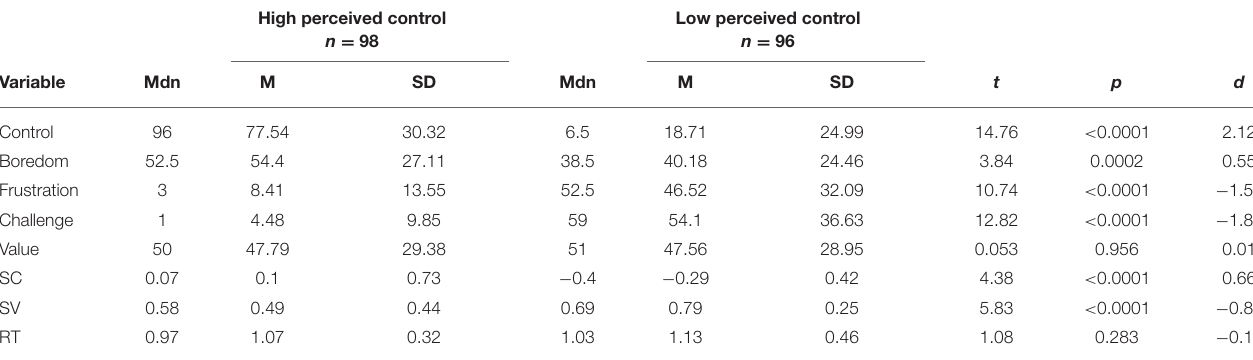
TABLE 3 | Descriptive statistics for all variables and effect sizes (Study 1). High perceived control n = 98